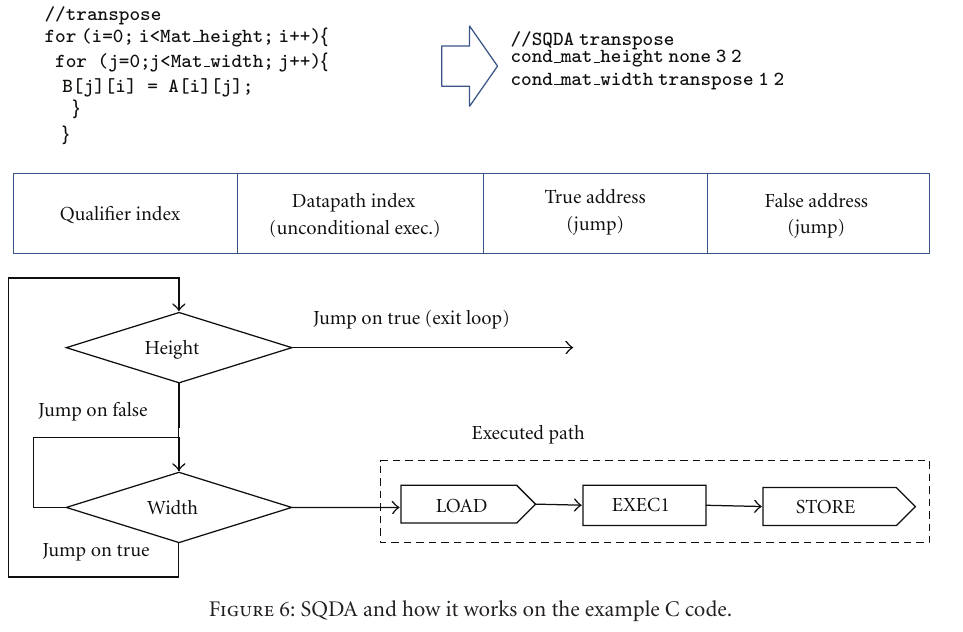
Figure 6: SQDA and how it works on the example C code.